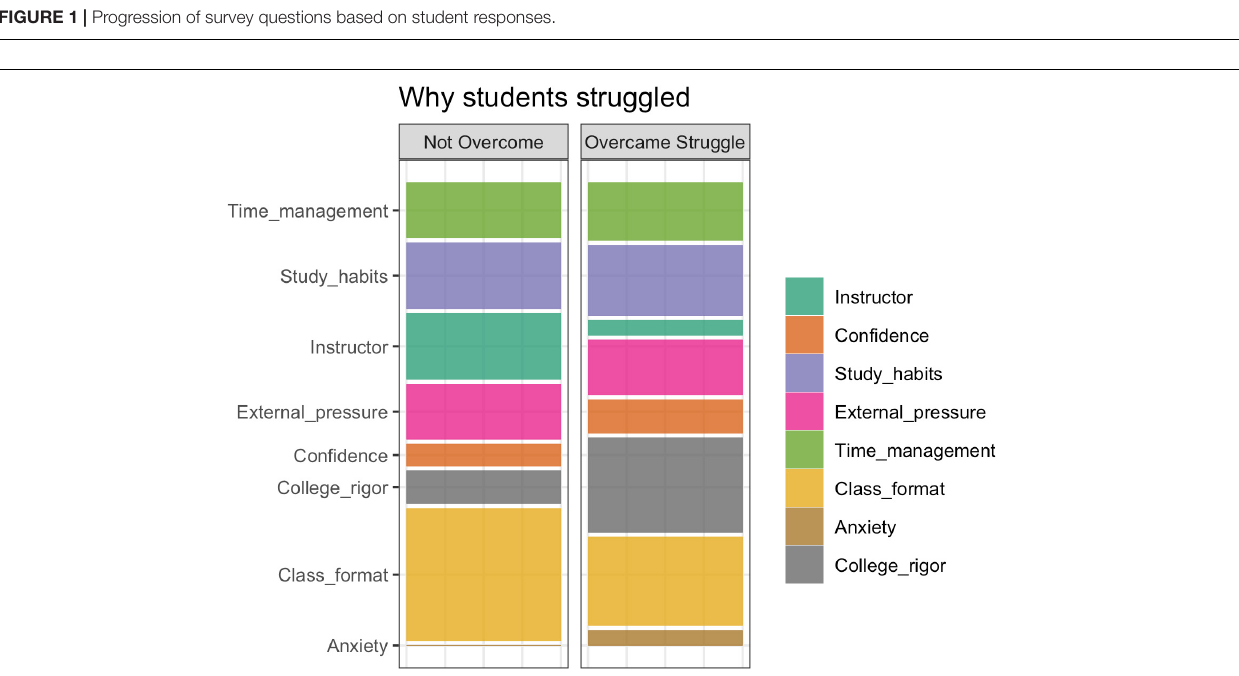
FIGURE 1 | Progression of survey questions based on student